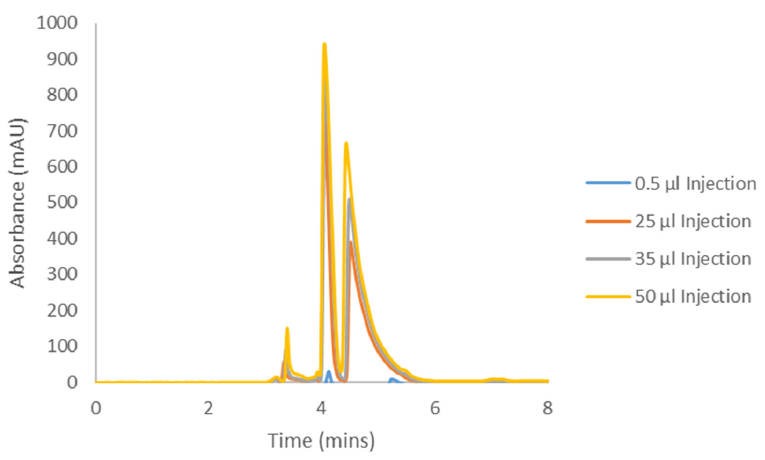
Figure 7. Preparative loading of CBL with a sample concentration of 19.0 mg/mL on CHIRALPAK ® IK with Hex − DCM = 60 − 40.